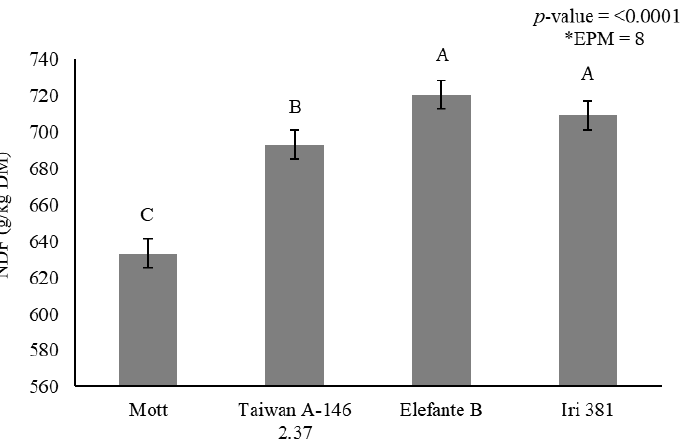
Figure 3. Stem neutral detergent fiber (NDF) (g/kg dry matter) as affected by genotype for elephant- grass at Garanhuns, Pernambuco, Brazil. *EPM = Standard error of the means. There was no difference in stem NDF concentration between rainy and dry season when irrigation was used, while rainfed treatments had lower stem NDF concentration during the dry season when compared to the rainy season (Table 7). Stem IVDDM was affected by irrigation × season ( p = 0.0002) (Table 7) and genotype × season interactions ( p < 0.0001) (Table 8). During the rainy season, IVDDM did not show a difference between irrigated and rainfed conditions, when compared to dry season (Table 7). There was a decrease in IVDDM during the rainy season compared to the dry season (Table 8). Mott and Taiwan A-146 2.37 showed greater IVDDM compared to other genotypes and did not differ from each other (Table